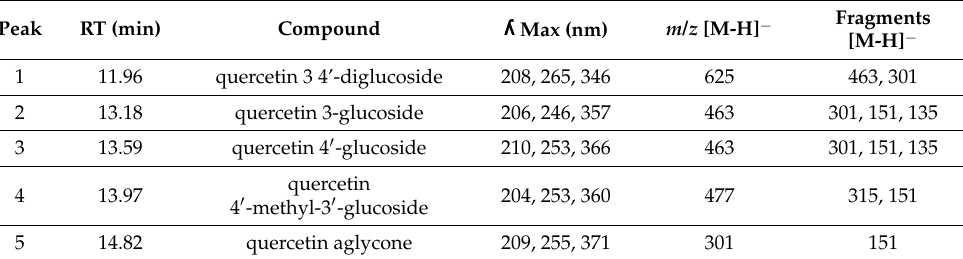
Table 2. Identified compounds in A. cepa extracts according to (RT), UV-vis ( λ max), and MS and MSn data ( m / z and fragments MS/MS).